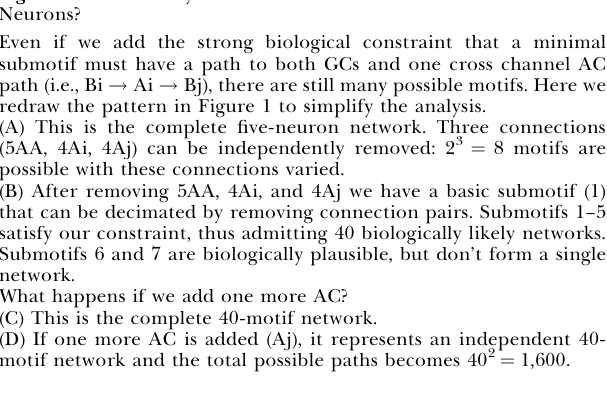
Figure S2. How Many Motifs Can You Make with Five or Six Retinal Neurons?